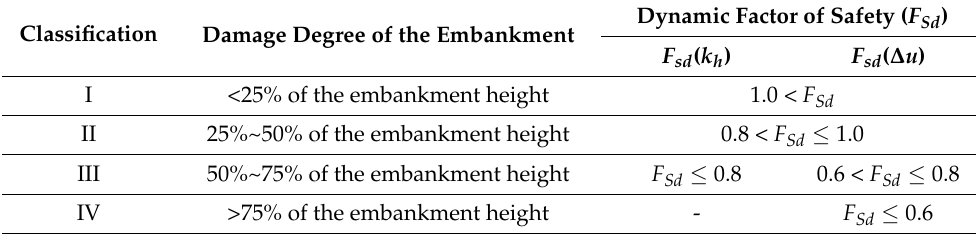
Table 4. Evaluation of seismic capacity of a river embankment based on F Sd .